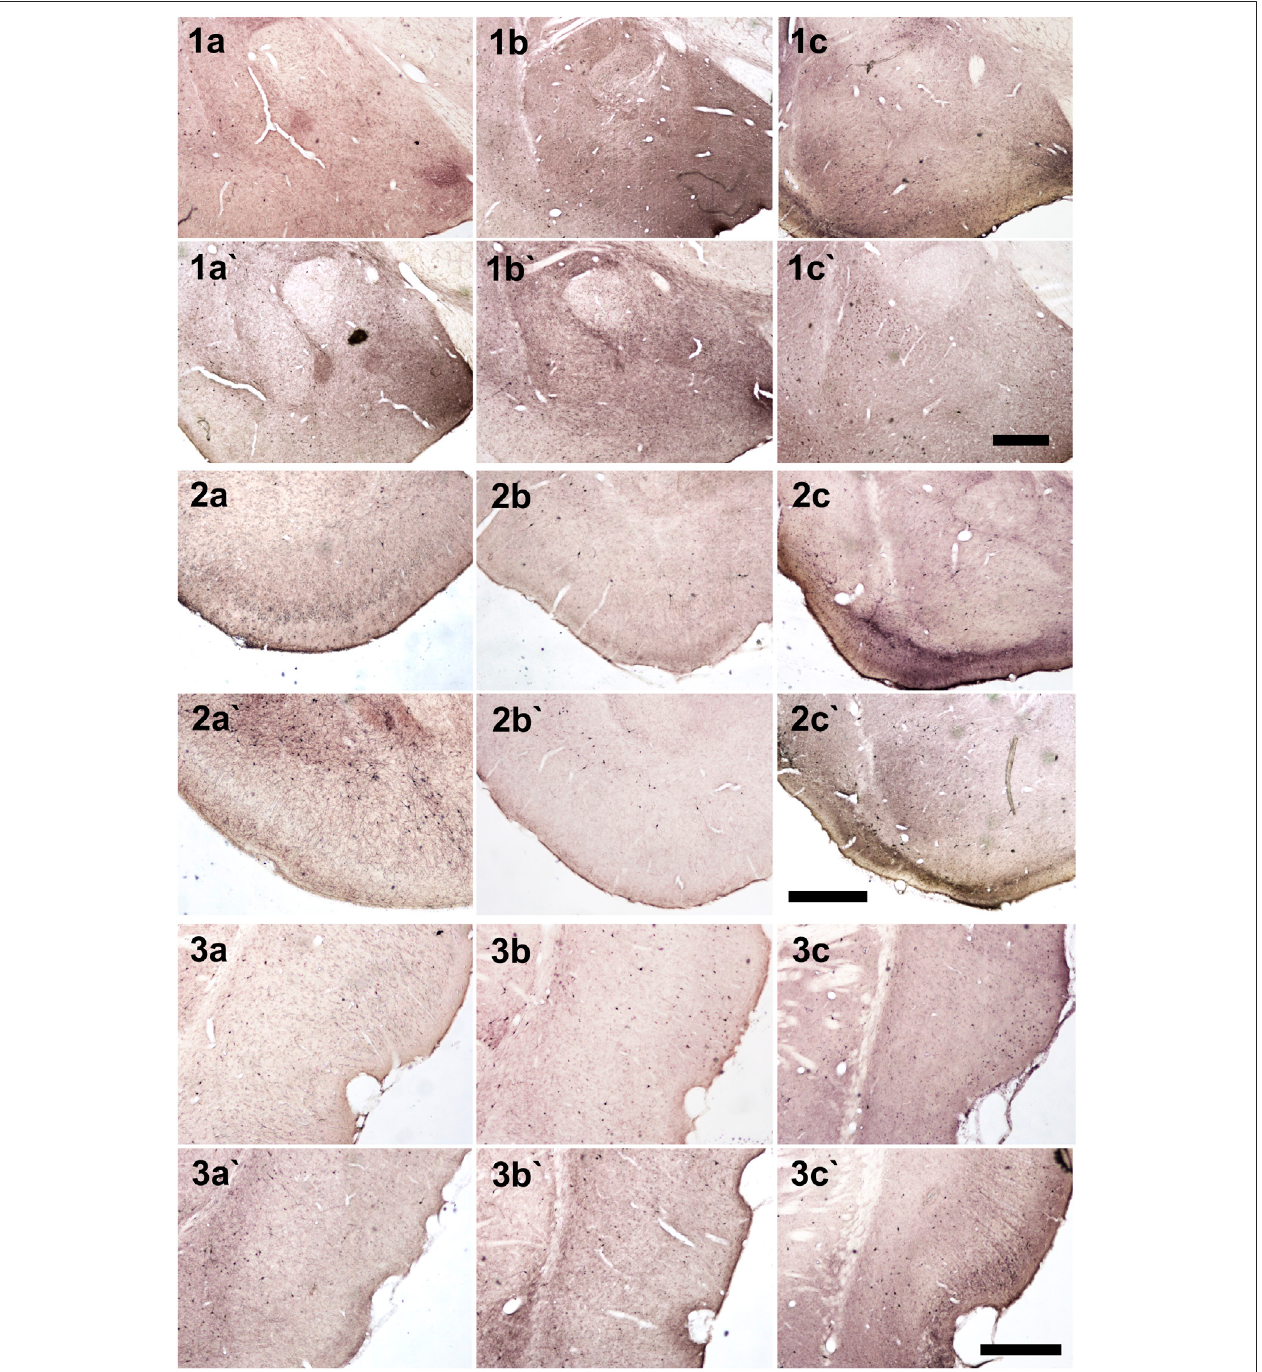
FIGURE6| PhotomicrographsofNPY+cellsindifferentbrainregions.(1)Amygdala,(2)Piriformcortex,(3)Entorhinalcortex(a,bandc)Anx(a`,b`andc`)Non-Anx (a, a`) Controls (b, b`) NoSE (c, c`) SE. Scale bars: 500 μ m.